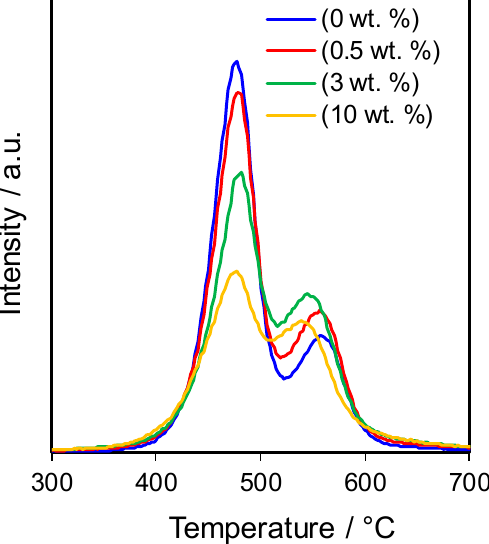
Figure 4. Reactively-formed propene from propylamine temperature-programmed reaction spectroscopy (TPRS) over xGa/HZSM-5.